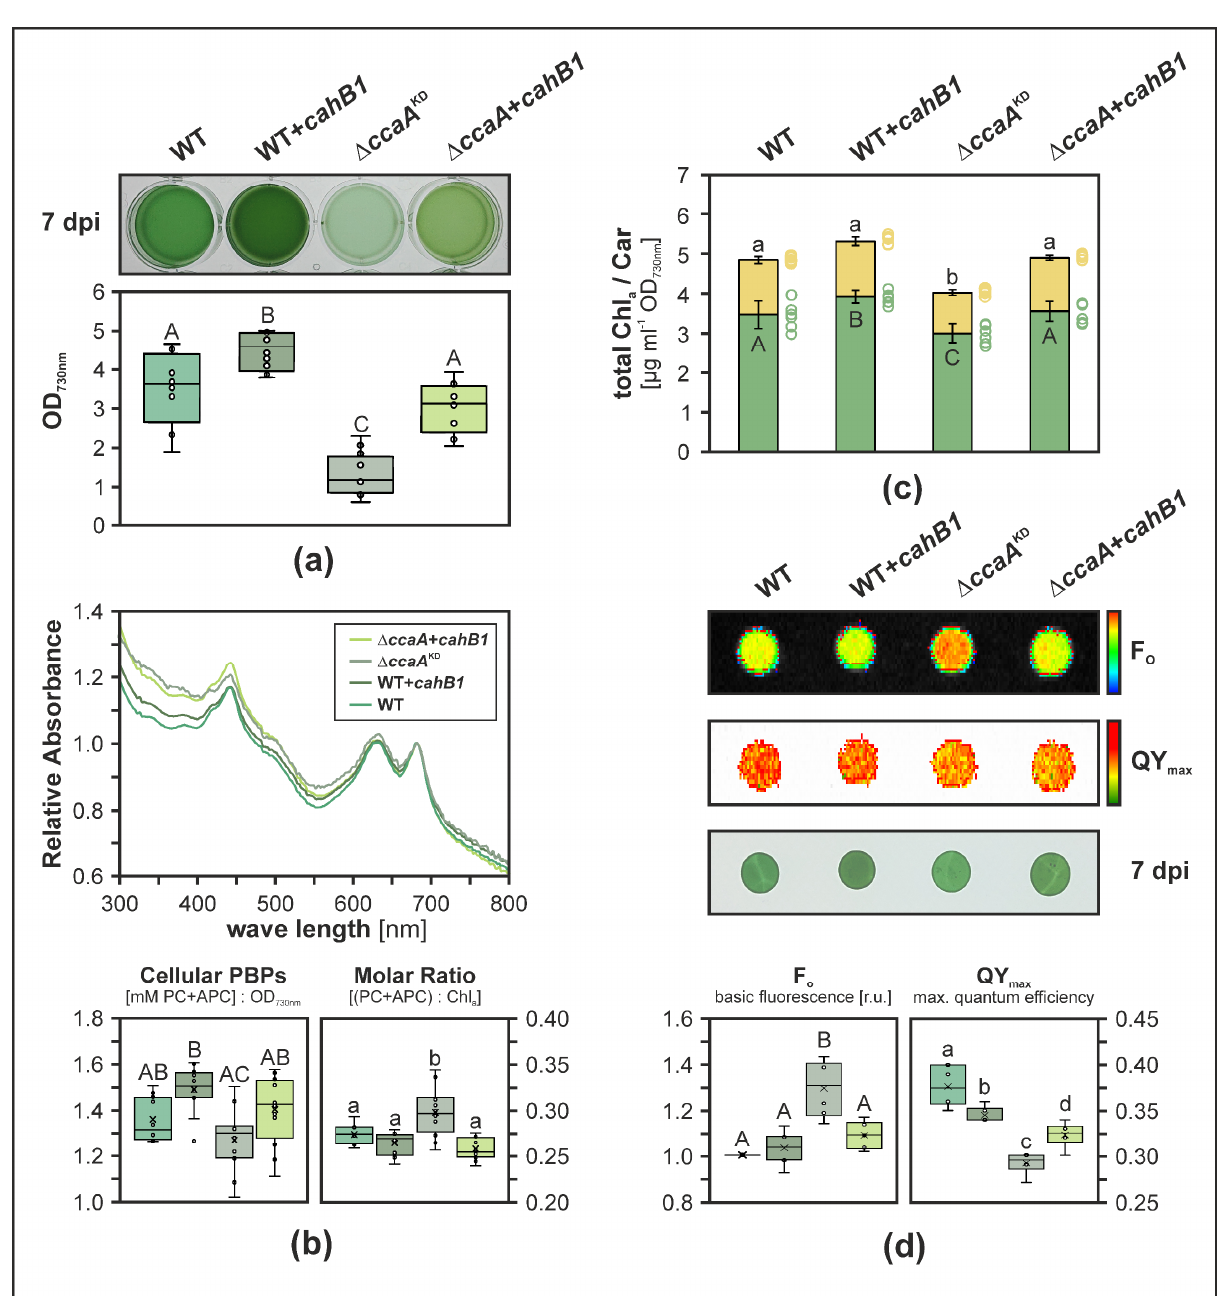
Figure 2. CahB1 complements loss of Synechocystis CcaA. ( a ) Representative photoautotrophic culture phenotypes. dpi, days past inoculation. Boxplots represent data from n = 12 biological replicates. ( b ) Average whole cell UV/Vis absorbance spectra normalized to the chlorophyll a absorbance maximum at λ = 683 nm (top), and derived estimates of total cellular phycobiliproteins (PBPs) normalized to OD 730nm (bottom left) and molar PBPs-to-chlorophyll a (Chl a ) ratios (bottom right). PC, phycocyanin; APC, allophycocyanin; n = 12 biological replicates. ( c ) Cellular chlorophyll a and ca- rotenoid (Car) contents of OD 730nm = 0.75 cell equivalents. Horizontal lines show average values, error bars show sample standard deviations, and dots show individual replicate values. n = 6 bio- logical replicates. ( d ) Photosynthetic performance parameters F o (minimal fluorescence relative to WT) and QY max (photosystem II maximum quantum yield) of 1 mL OD 730nm = 0.75 cell equivalents harvested 7 dpi dropped onto BG11 agar. F o normalized to corresponding WT samples. n = 6 bio- logical replicates. Letters indicate statistically significant differences ( p ≤ 0.05) according to multiple simultaneous comparisons in post hoc Bonferroni–Holm-corrected Tukey HSD (honest significant difference) tests after statistically significant among-group differences were detected by one-way ANOVA (( a ) p = 4.13 × 10 −14 ; ( b ) p = 9.00 × 10 −4 [cellular PBPs] and p = 2.48 × 10 −4 [molar ratio PBPs:Chl a ]; ( c ) p = 7.18 × 10 −5 [Chl a ] and p = 8.27 × 10 −7 [Car]; ( d ) p = 1.06 × 10 −5 [F o ] and p = 4.56 × 10 −8 [QY max ]).